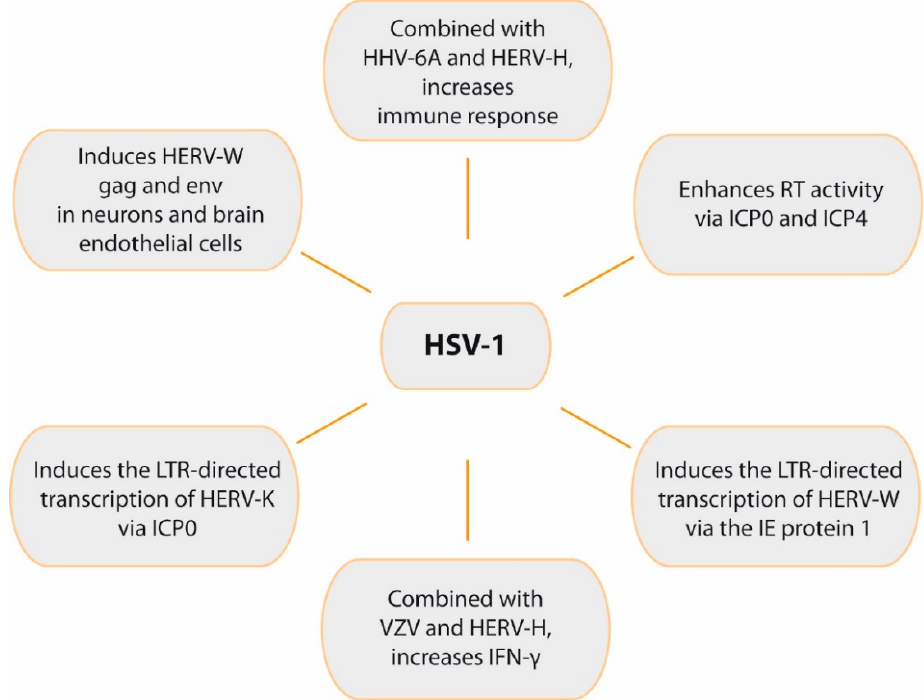
Figure 6. Role of HSV-1 in HERVs activation and immune response. The figure summarizes relevant effects of HSV-1 on HERVs transcription and the synergistic effects of both viruses on immune response.